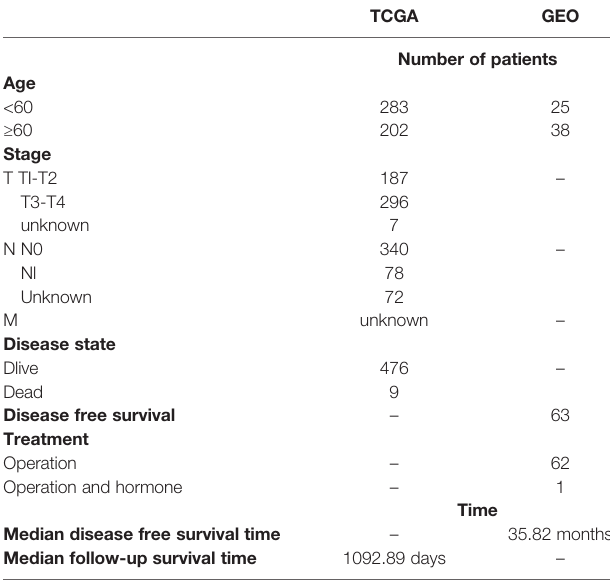
TABLE 1 | Clinical characteristic of patients with prostate